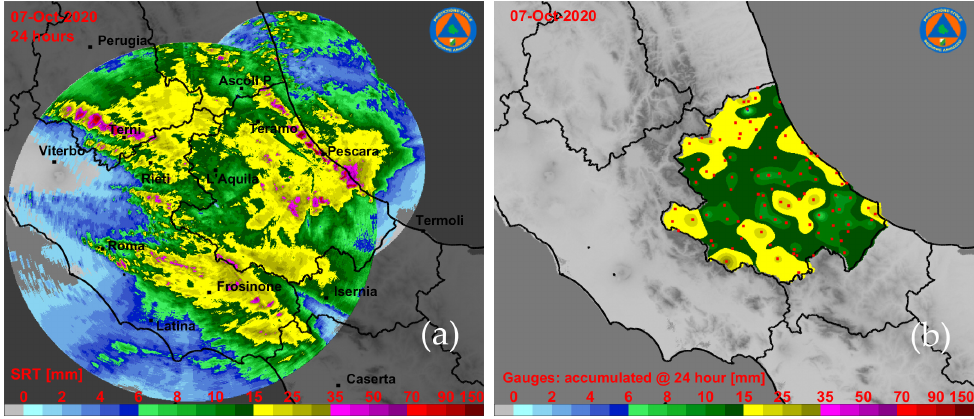
Figure 8. 24-h rainfall accumulated during the event occurring on 7 October, 2020: ( a ) radar composite domain and the ( b ) rain-gauge network within the Abruzzo region (see Figure 1). As mentioned, the 2D products, generated by 3D observations of every single radar in the RAMP processing chain, are remapped in Cartesian coordinates by means of the CRAMS algorithm for the composite generation. As an example, we show CRAMS mo- saicked products for the hailstorm, which occurred on 10 July, 2019, along the Abruzzo coastline, listed in Table 4. Details on the cyclogenesis of this unusual hail-bearing storm, with supercell characteristics, are provided and discussed in [39]. Figure 9 shows for this event some composite products described in Table 2: vertically maximum intensity (a), rainfall rate (b), vertically integrated liquid (c), probability of hail (d), and convective storm detection (e). The POH composite map evidences the presence of hail near the Adriatic coast, confirmed by ground observations, as well as high values of vertically integrated liquid [39].